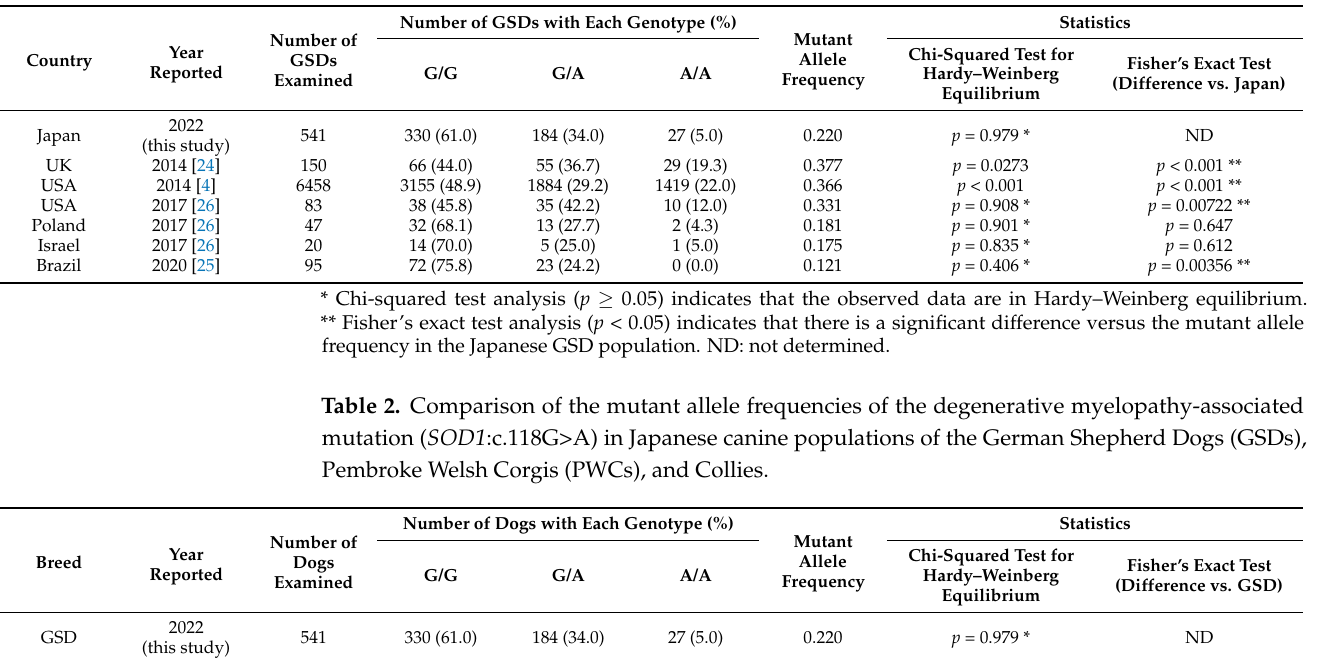
Table 1. Comparison of the mutant allele frequencies of degenerative myelopathy-associated muta- tion ( SOD1 :c.118G>A) in German Shepherd Dogs (GSDs) in Japan and elsewhere.